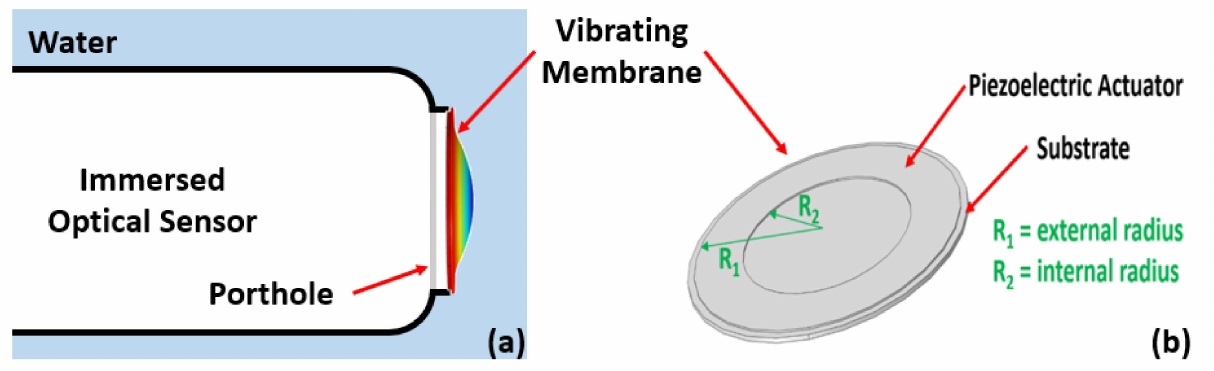
Figure 1. ( a ) Schematic view of the vibrating membrane principle, and ( b ) its main parts and